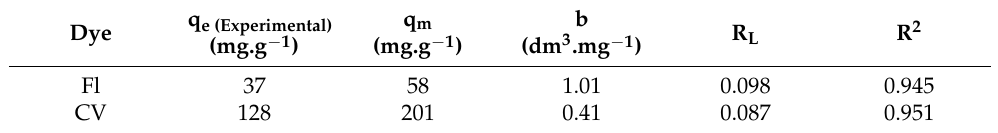
Figure 7. Adsorption isotherms of Fl and CV at 298 K: ( A ) Langmuir adsorption isotherm, and ( B ) Freundlich adsorption isotherm. Table 2. Langmuir parameters for the adsorption process at 298 K.